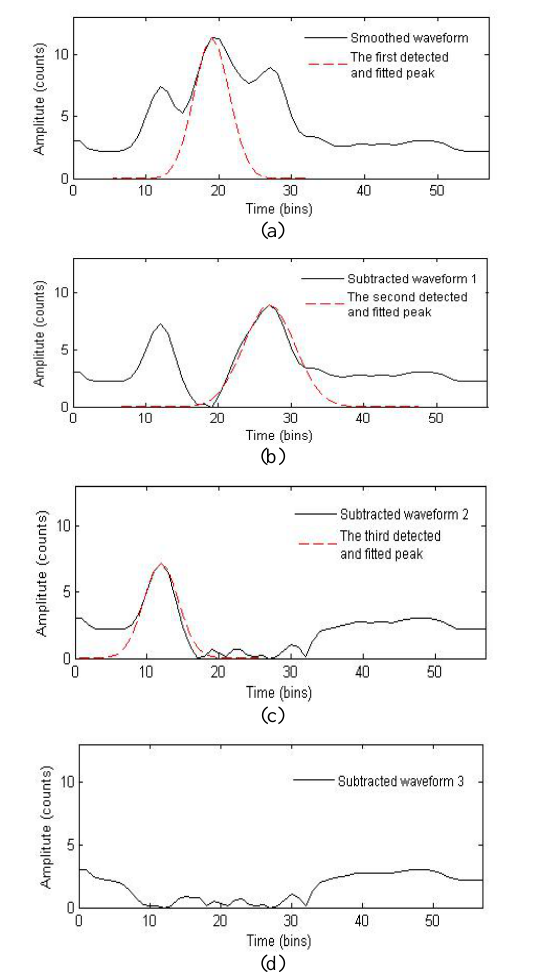
Figure 3. The demonstration of the PWD decomposition